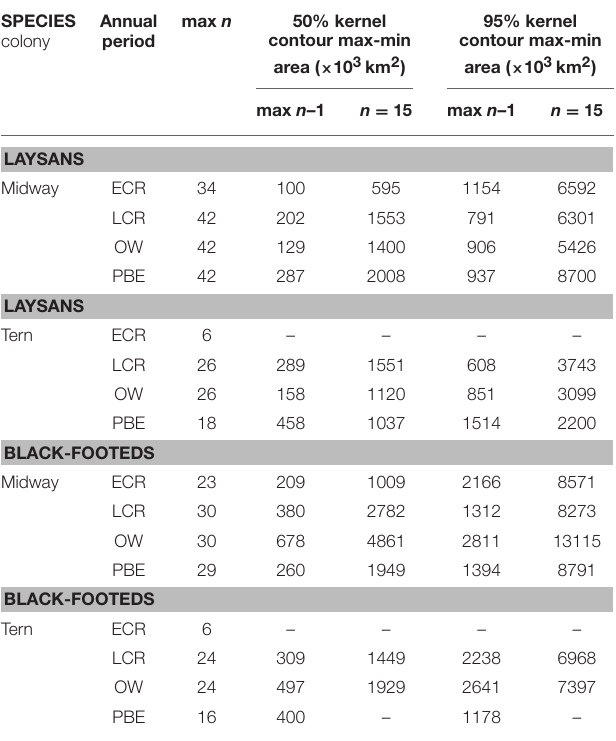
TABLE 3 | Range in areas of 50 and 95% contours from pooled KDE with sample sizes of maximum n less one and n = 15